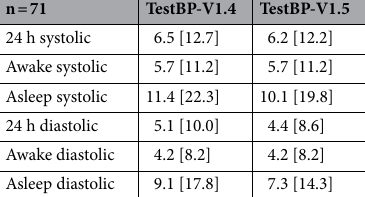
Table 4. Standard error of the measurement between the TestBP-V1.4 and TestBP-V1.5 with the RefBP. Data are standard error of the measurements [95% confidence interval].